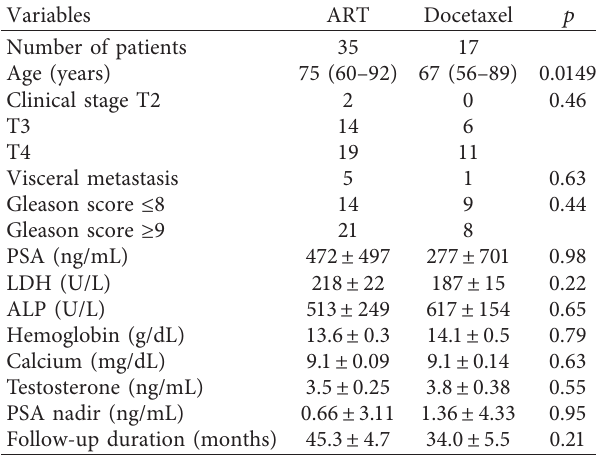
Table 1: Baseline characteristics of patients treated with ART and